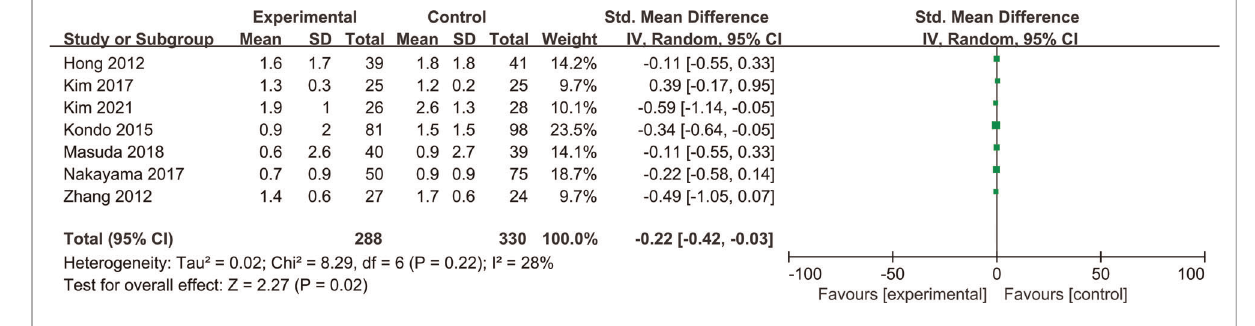
FIGURE 9 Forest pot for KT1000/2000 arthrometer measurement.